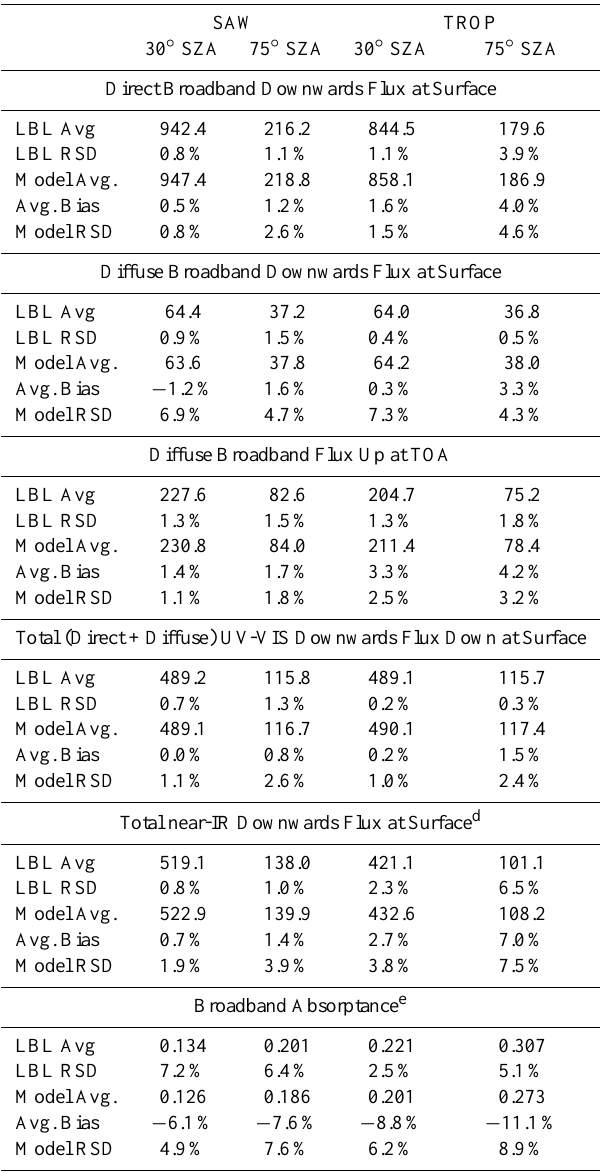
Table A2. Case 1: summary of statistics for the Rayleigh atmo- sphere (excluding only models #22–23) a , b , c